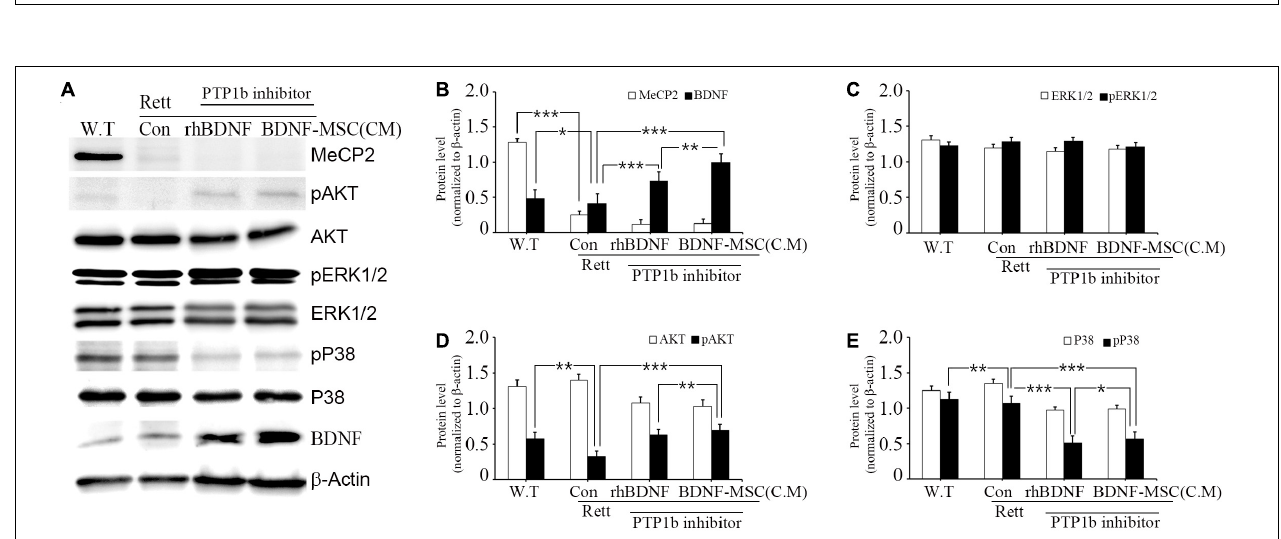
FIGURE 7 | Relative levels of BDNF, AKT, and MAPK following BDNF or BDNF-MSC treatment in MECP2 knockout mice. The activity of the downstream signaling pathways of BDNF in mice was determined using western blotting (A) . Phosphorylation of MAPK represents a change in the activities of cell signaling pathways. (B–E) Relative intensity is represented in graphs. * p < 0.05, ** p < 0.01, *** p < 0.001.